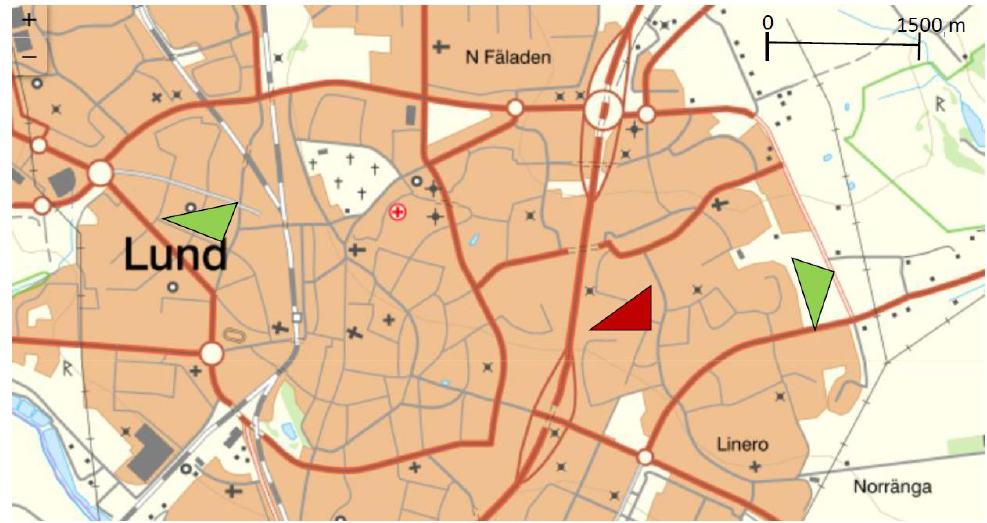
Figure 4. Map of Lund showing the site where green space is lost (red triangle) and two possible offset sites (green triangles).